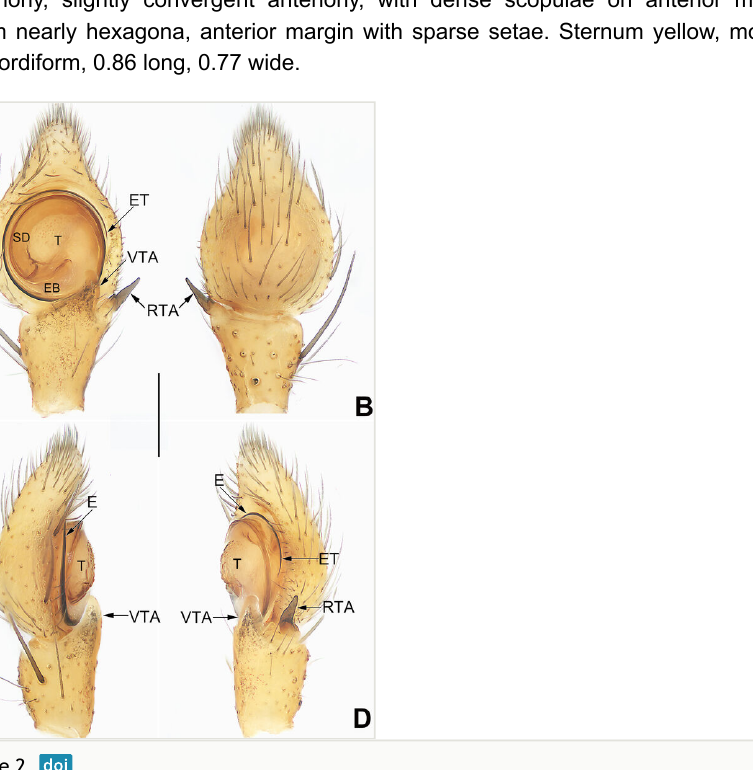
Figure 2. Male left palp of the holotype of Synema guiyang sp. nov. A Ventral view; B Dorsal view; C Prolateral view; D Retrolateral view. Abbreviations: E = embolus; EB = embolar base; ET = embolar tip; ITA = intermediate tibial apophysis; RTA = retrolateral tibial apophysis; SD = sperm duct; T = tegulum; VTA = ventral tibial apophysis. Scale bar: 0.2 mm (equal for